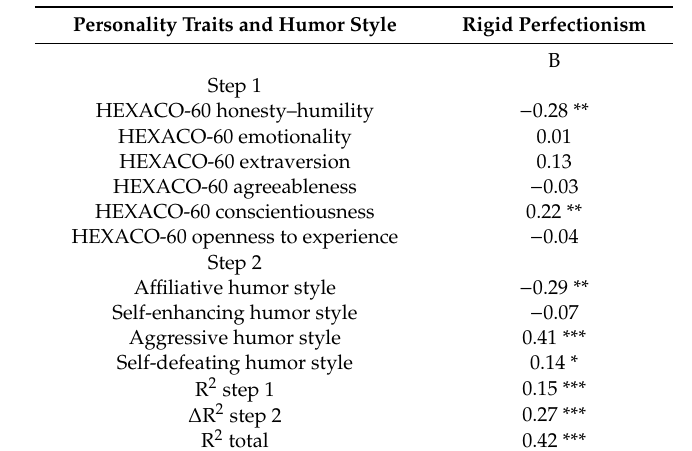
Table 2. The contributions of personality traits HEXACO-60 (first step) and Humor Styles (second step) to rigid perfectionism.